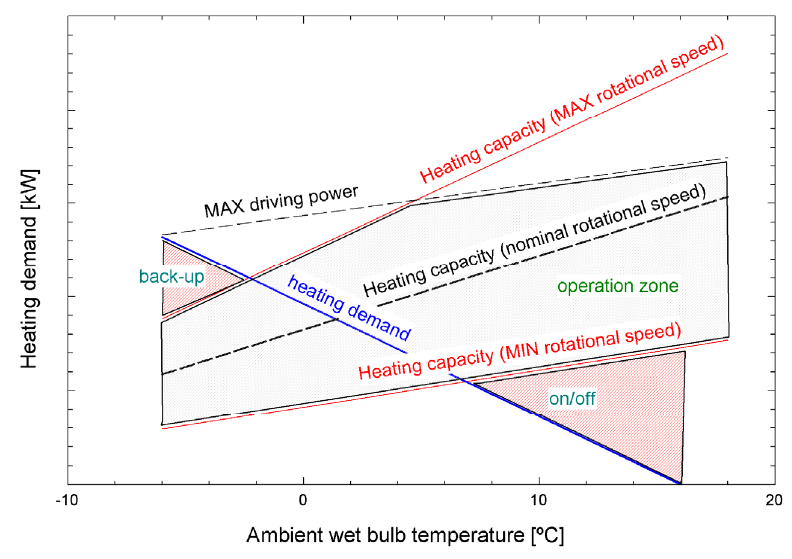
Figure 5. Coupling between demand and performance of the heat pump.